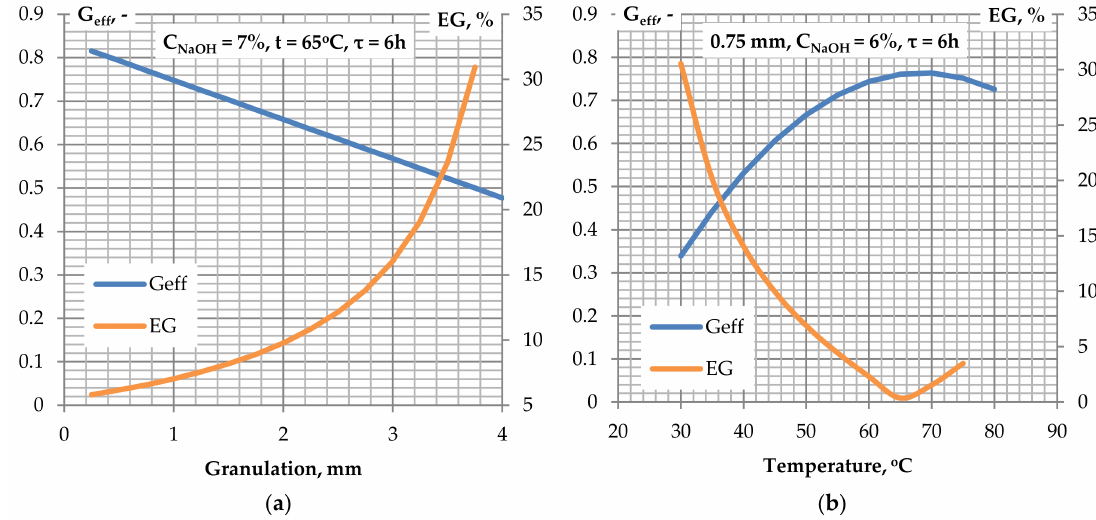
Figure 6. Effect of granulation ( a ) and pre-treatment temperature ( b ) on the glucose efficiency and realative glucose efficiency